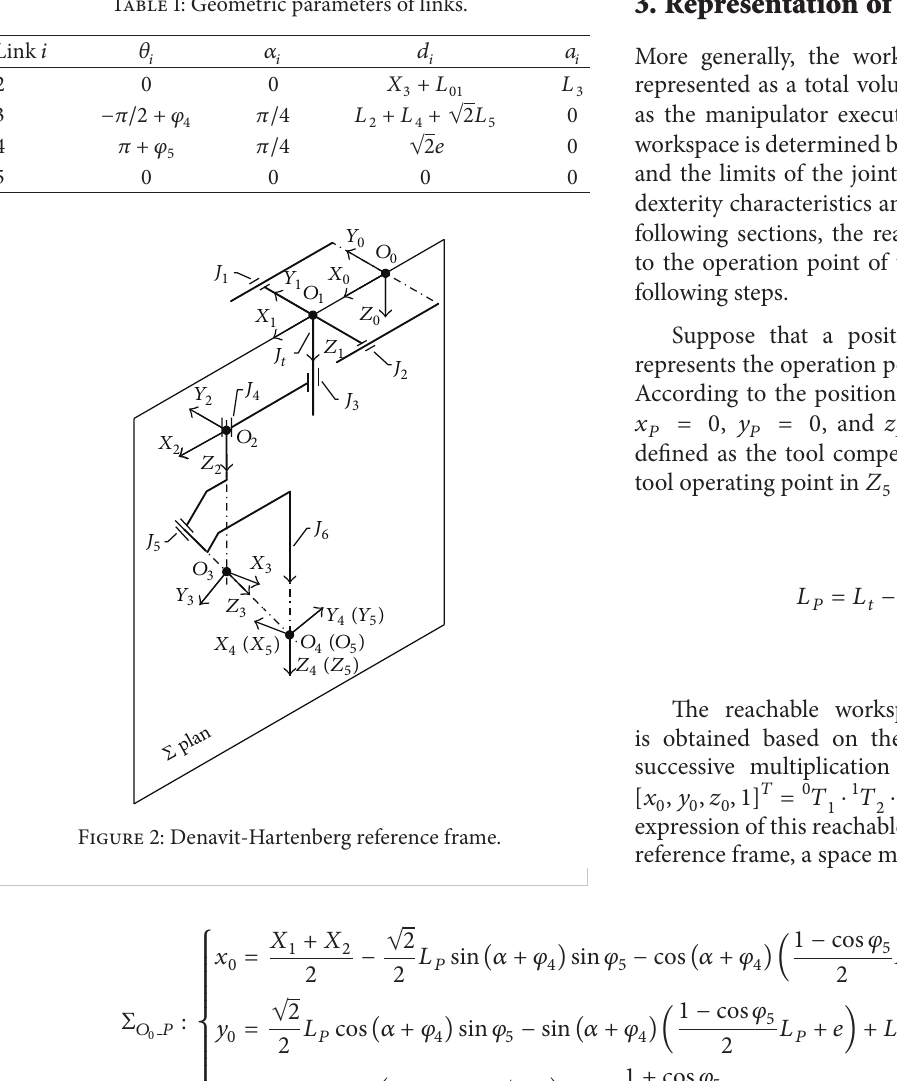
Table 1: Geometric parameters of links.